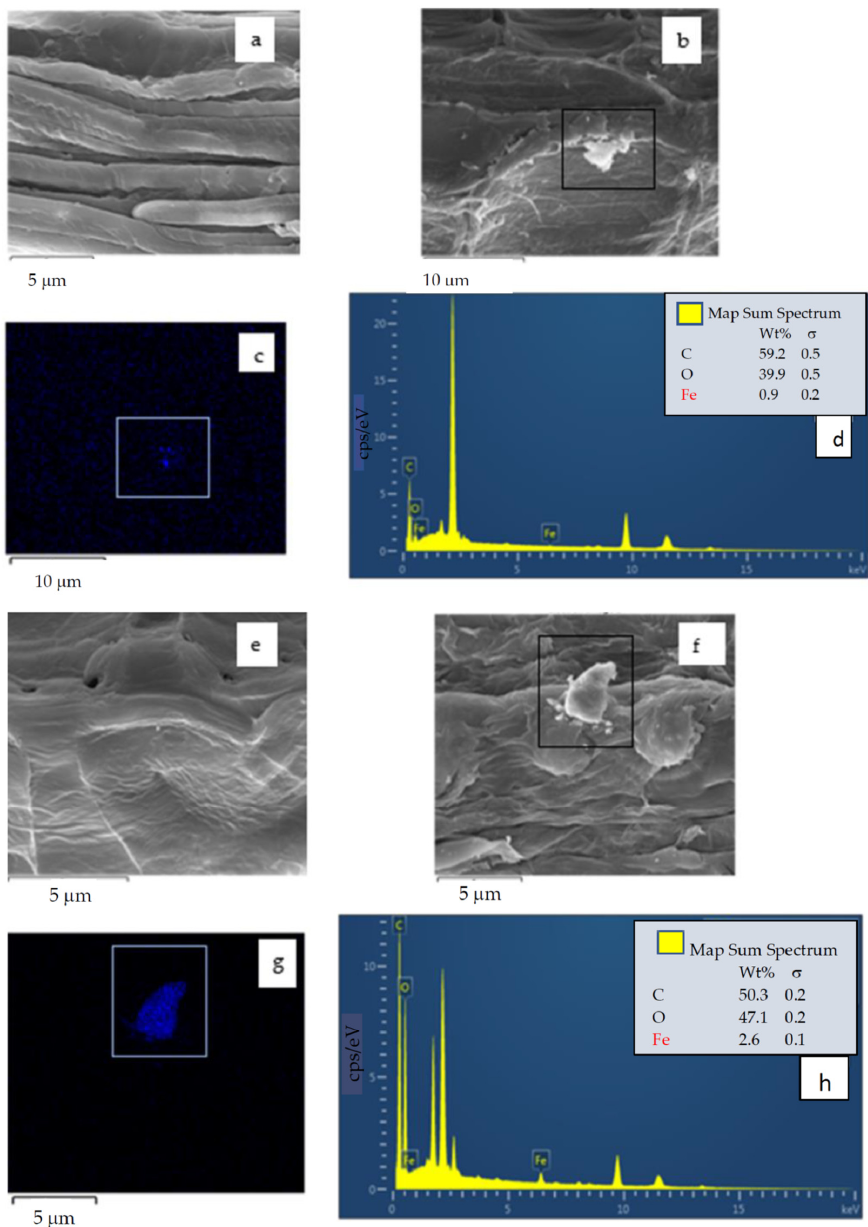
Figure 11. The SEM, elemental mapping analysis and EDX images of N–PPF ( a – d ) and C–PPF after adsorption ( e – h ).